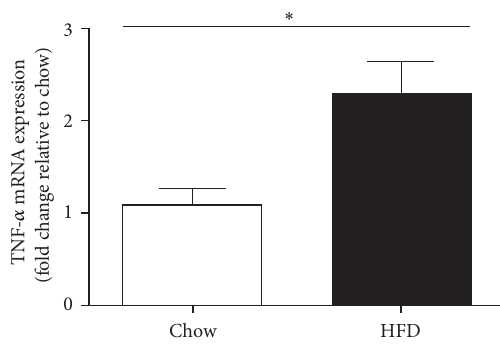
Figure 2: Elevated TNF- 𝛼 mRNA levels in the livers of mice on a high fat diet for 12 weeks. ∗ 𝑝 < 0.05 ; 𝑛 = 14 – 17 mice/group.